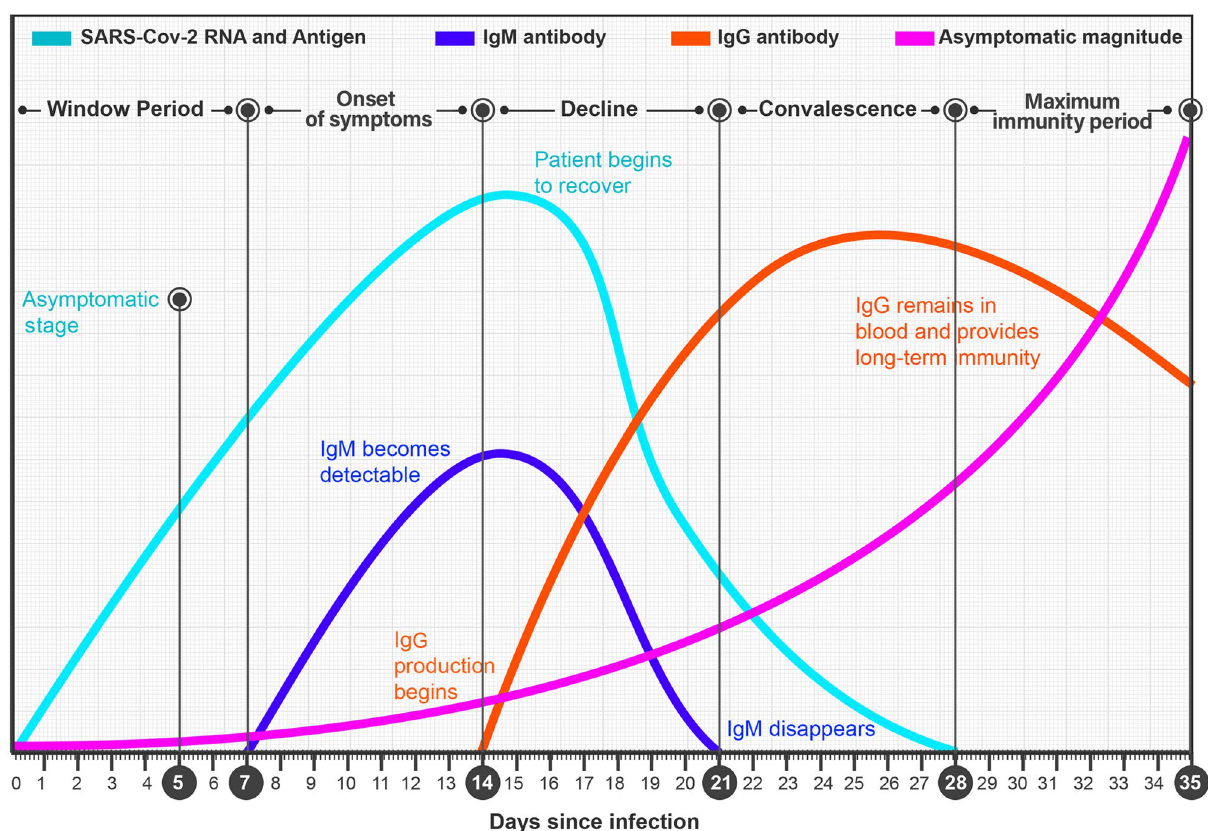
Fig. 6 Based on the unsatisfactory efficiency of COVID‑19 kits due to the detection lag of 7 and 14 days for appearing IgM and IgG in the serum of asymptomatic patients, porters would not be recognized, triggering the spread [63–66]